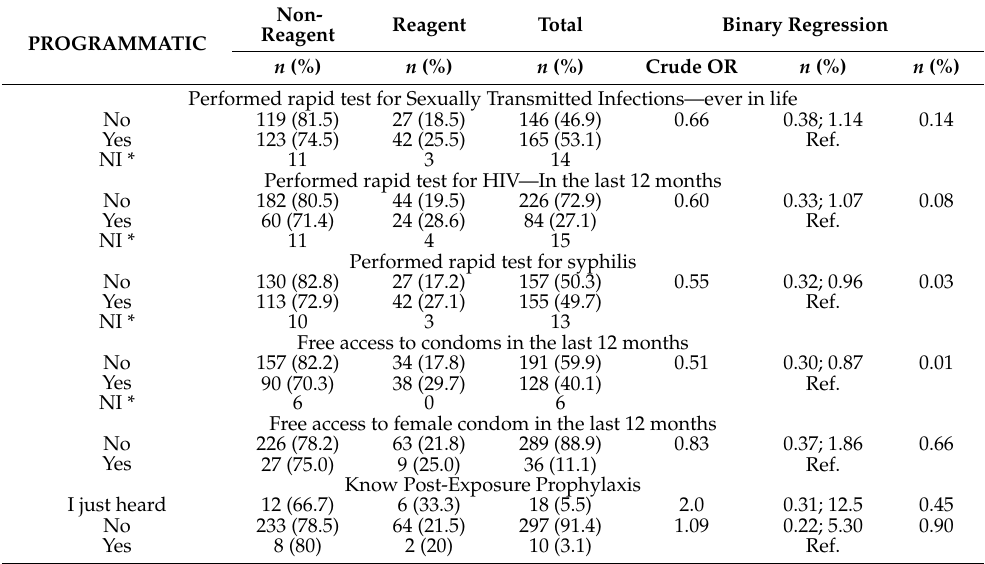
Table 3. Programmatic factors associated with serology for C. trachomatis among riverine, in the Brazilian Amazon,